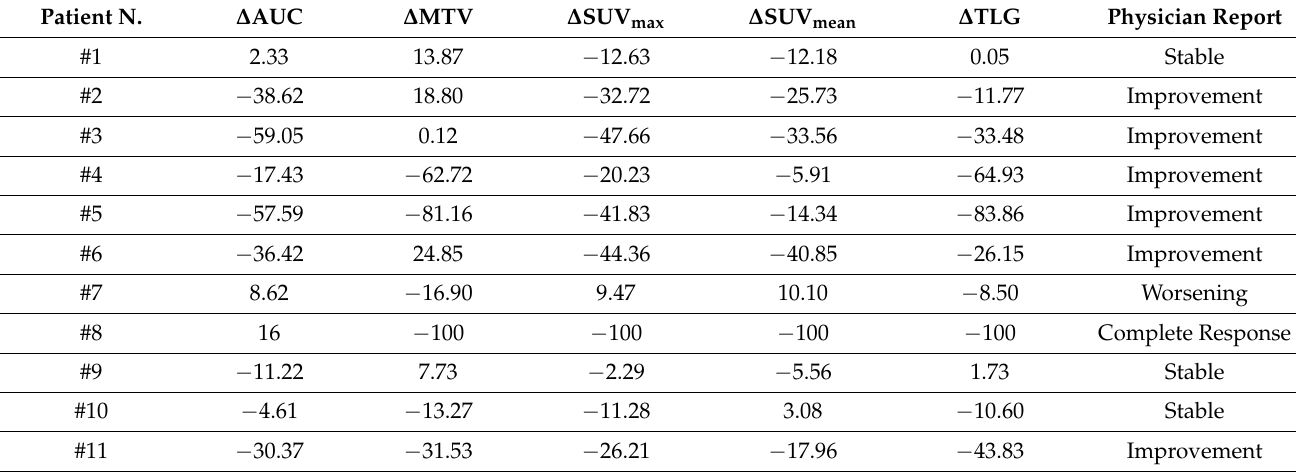
Table 1. Positron emission tomography (PET) parameter variations (%) between pre- and post-Gamma Knife (GK) treatment. Patient